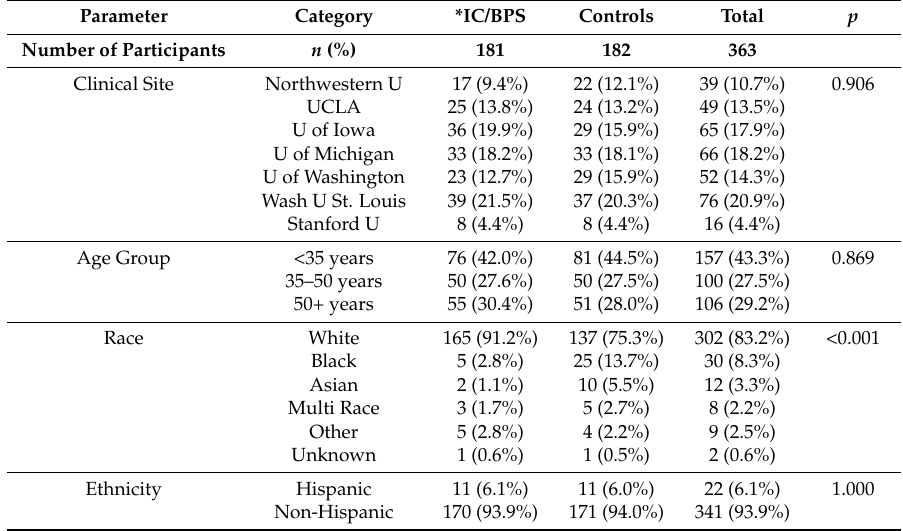
Table 1. Baseline Demographic